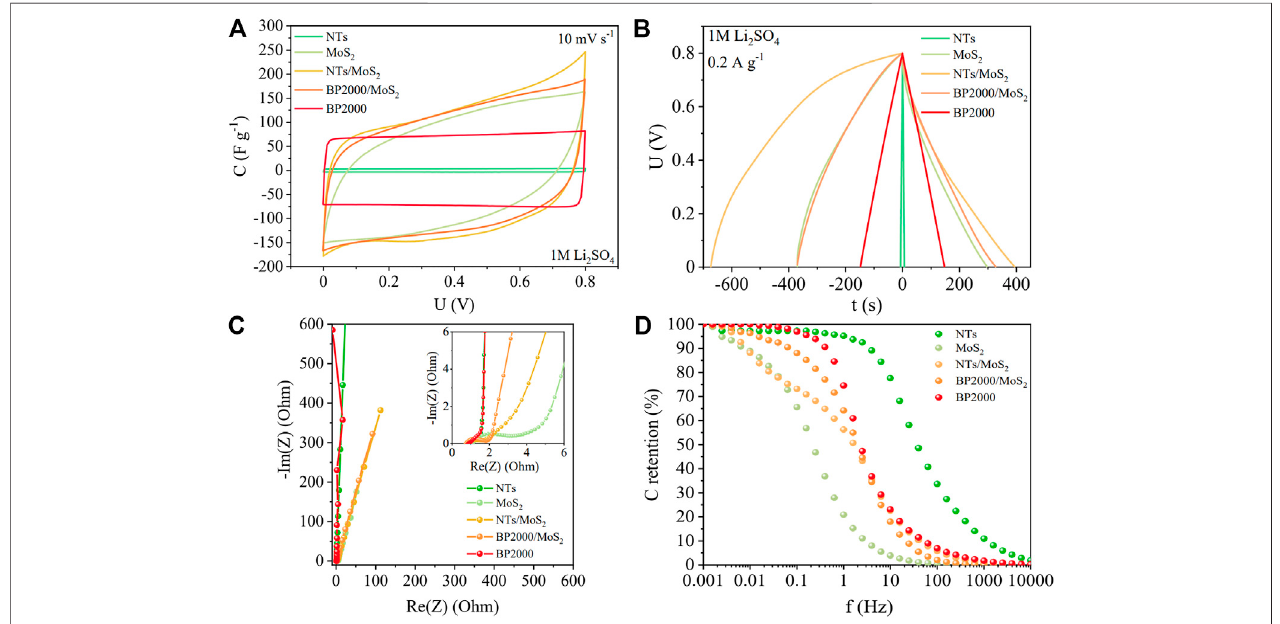
FIGURE7| ElectrochemicalperformanceofpureBP2000, NTs,MoS 2 ,and their MoS 2 compositematerials. (A) Cyclicvoltammograms, (B) galvanostatic charge/ discharge, (C) electrochemical impedance spectroscopy, and (D) capacitance retention vs. frequency.